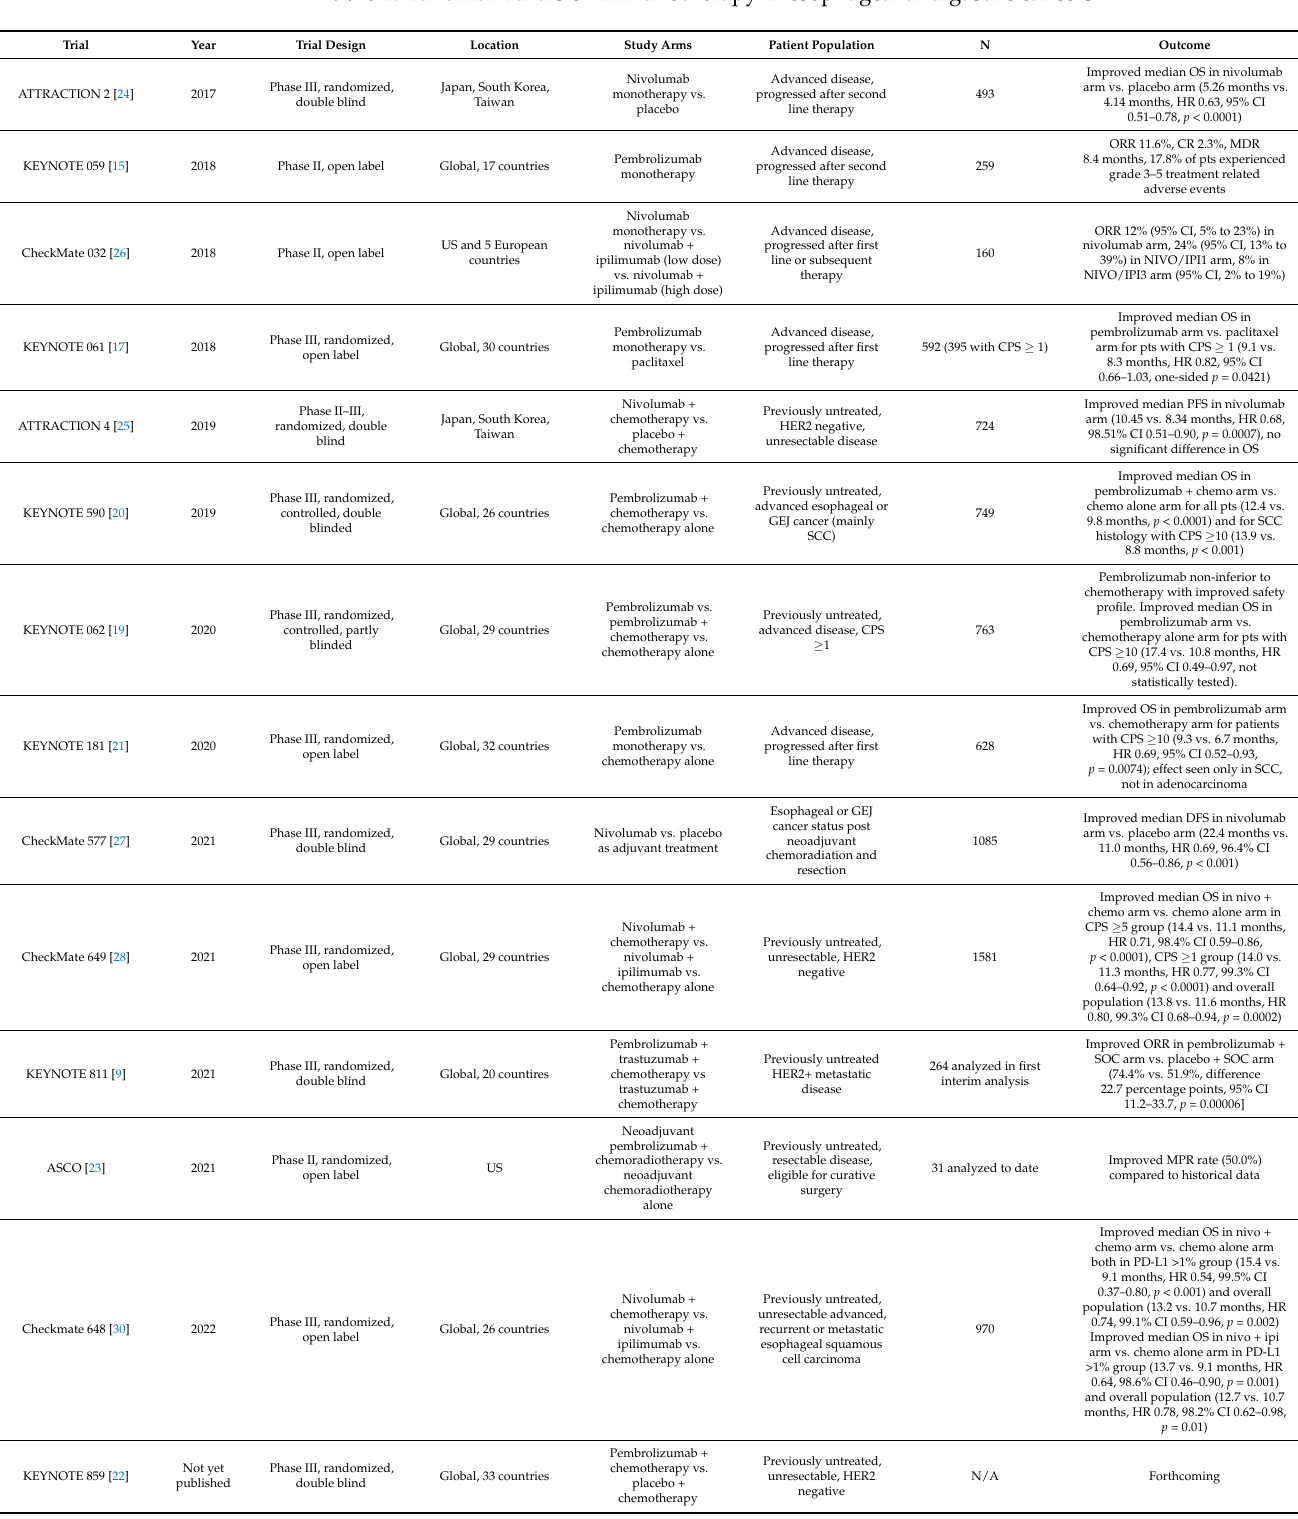
Table 1. Landmark trials of immunotherapy in esophageal and gastric